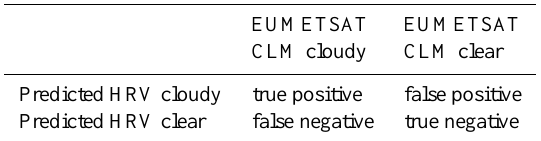
Table 1. Contingency table with binary classification cloudy and clear.